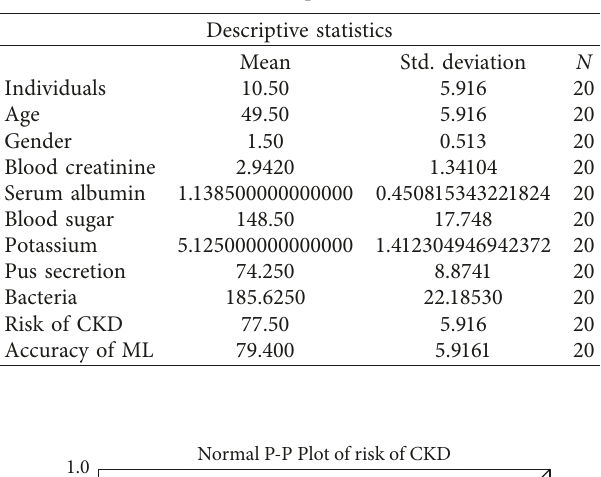
Table 4: Correlation